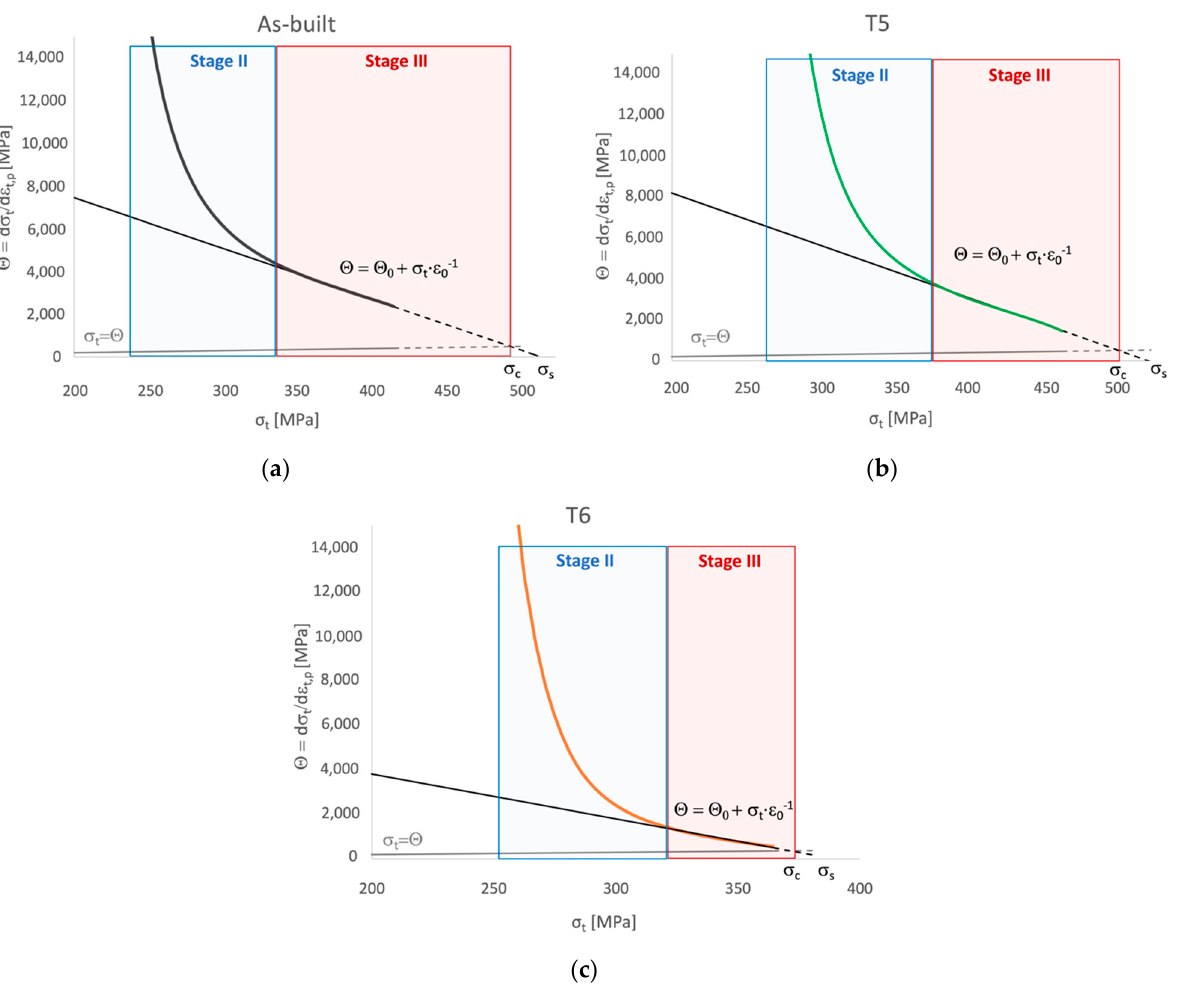
Figure 9. Kocks-Mecking (KM) diagram obtained for the AlSi7Mg PBF-LB alloy in the: ( a ) as-built (black line), ( b ) T5 (green line), and ( c ) T6R temper condition (orange line). Solid lines represent the elaboration of experimental data from tensile tests; dashed lines represent linear extrapolation from experimental data.